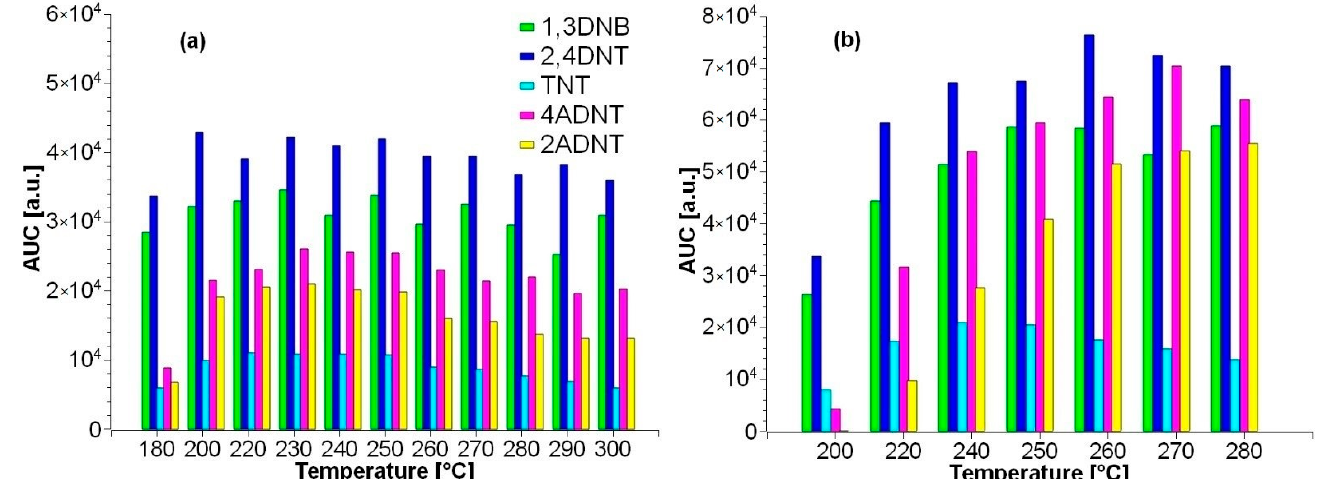
Figure 2. Temperature optimization for splitless injection using ( a ) packed quartz wool and ( b ) CarboFrit injection port liners. The optimum temperature was determined to be 230 °C for the quartz wool and 270 °C for the CarboFrit liner.